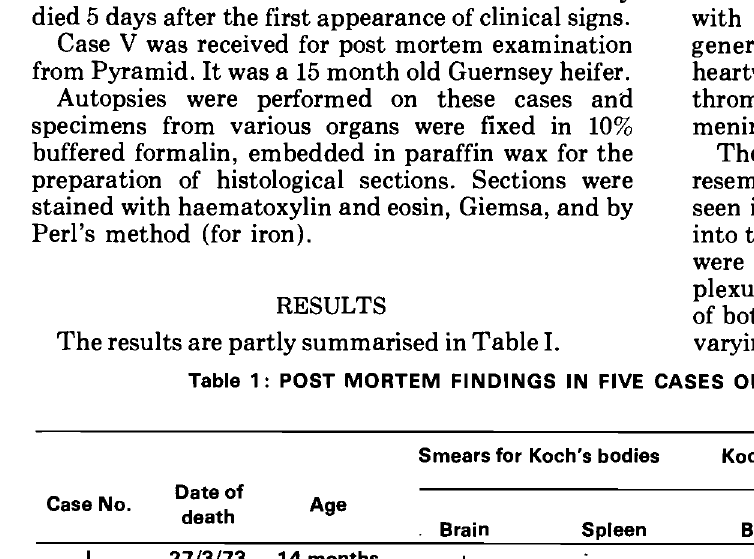
Smears for Koch's